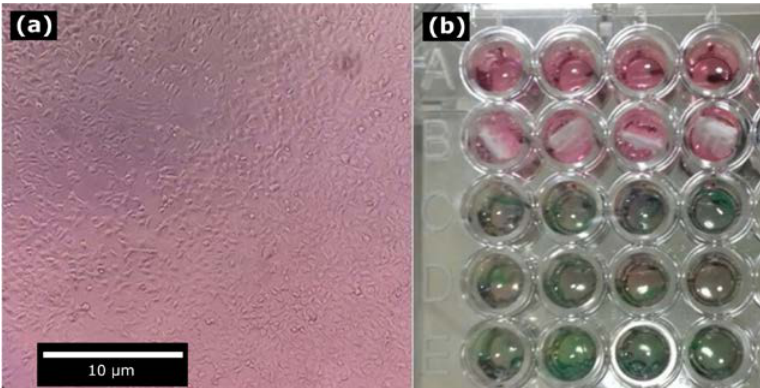
Figure 8. Cytotoxicity test in agreement with ISO 10993-5: ( a ) fibroblast confluency; and ( b ) cytotoxicity test of Type B bimodal scaffolds with cooling.